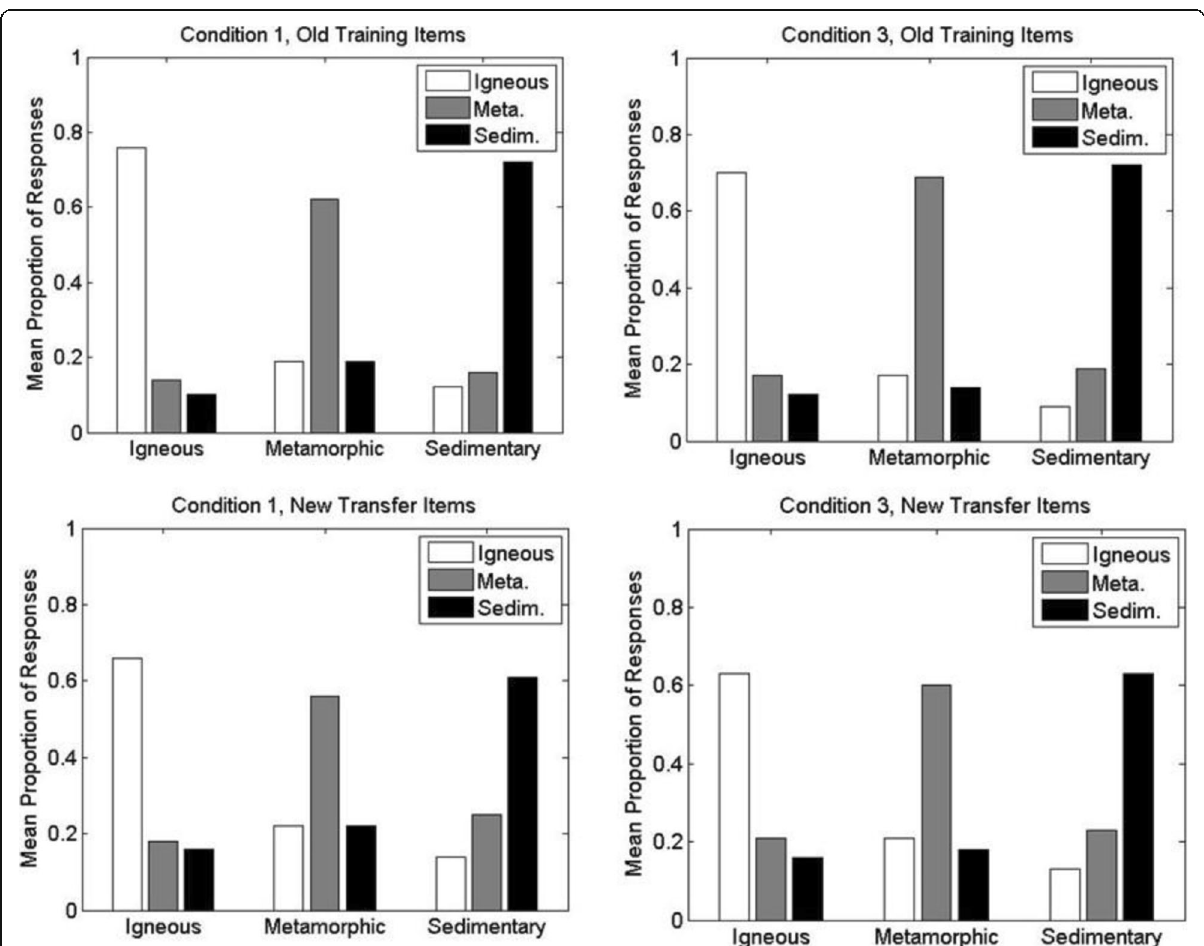
Fig. 8 Experiment 1A: mean proportion with which members of each high-level category were classified into the alternative high-level categories during the classification test phase of conditions 1 and 3. (Left panels) Condition 1; (right panels) condition 3; (upper panels) old training items; (lower panels) new transfer items. For example, within each panel, the white bar to the far left indicates the mean proportion with which members of the high- level igneous category were correctly classified as igneous, whereas the adjacent gray bar indicates the mean proportion with which members of the igneous category were incorrectly classified as metamorphic (Meta.). Sedim.